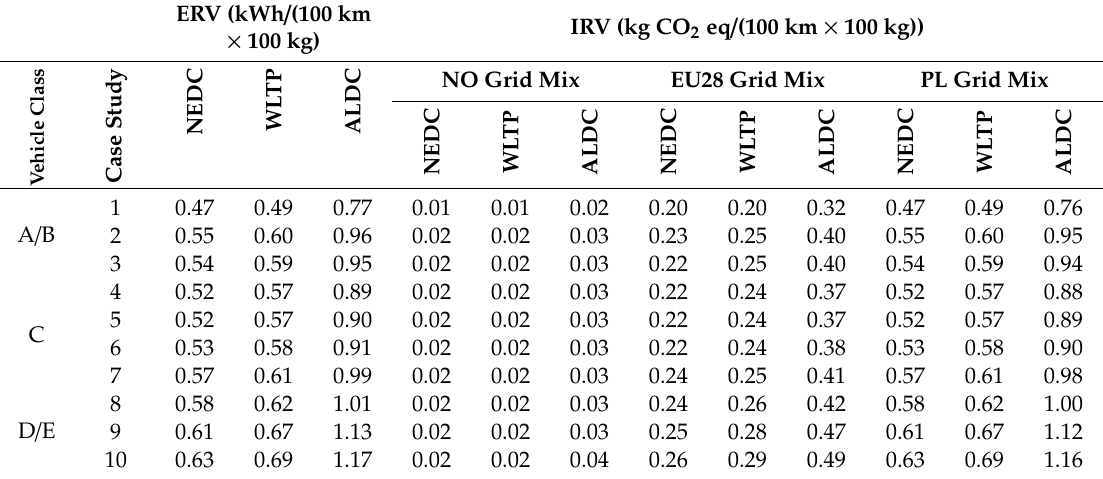
Table 1. Energy Reduction Value (ERV) and Impact Reduction Value (IRV) for all vehicle case